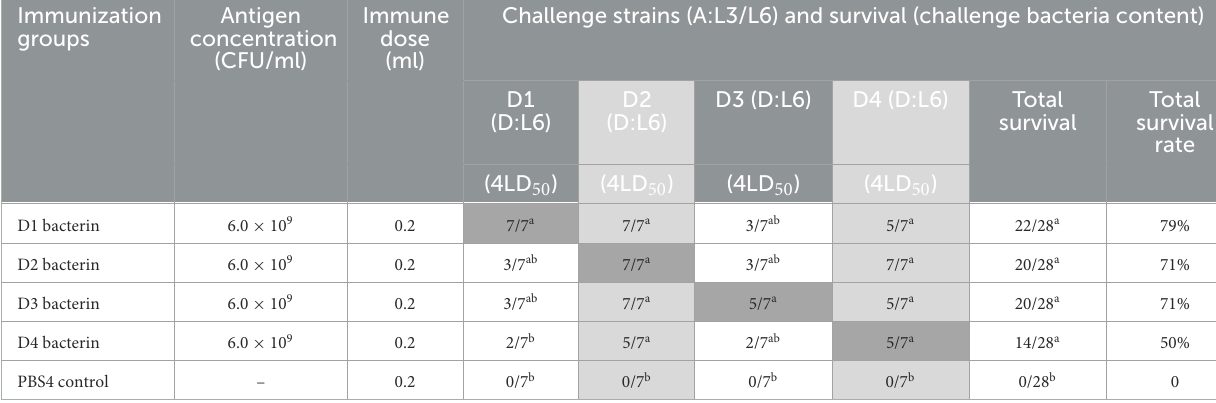
TABLE 5 Protection rate of D1–D4 bacterins against P. multocida strains (Test-4). Immunization groups